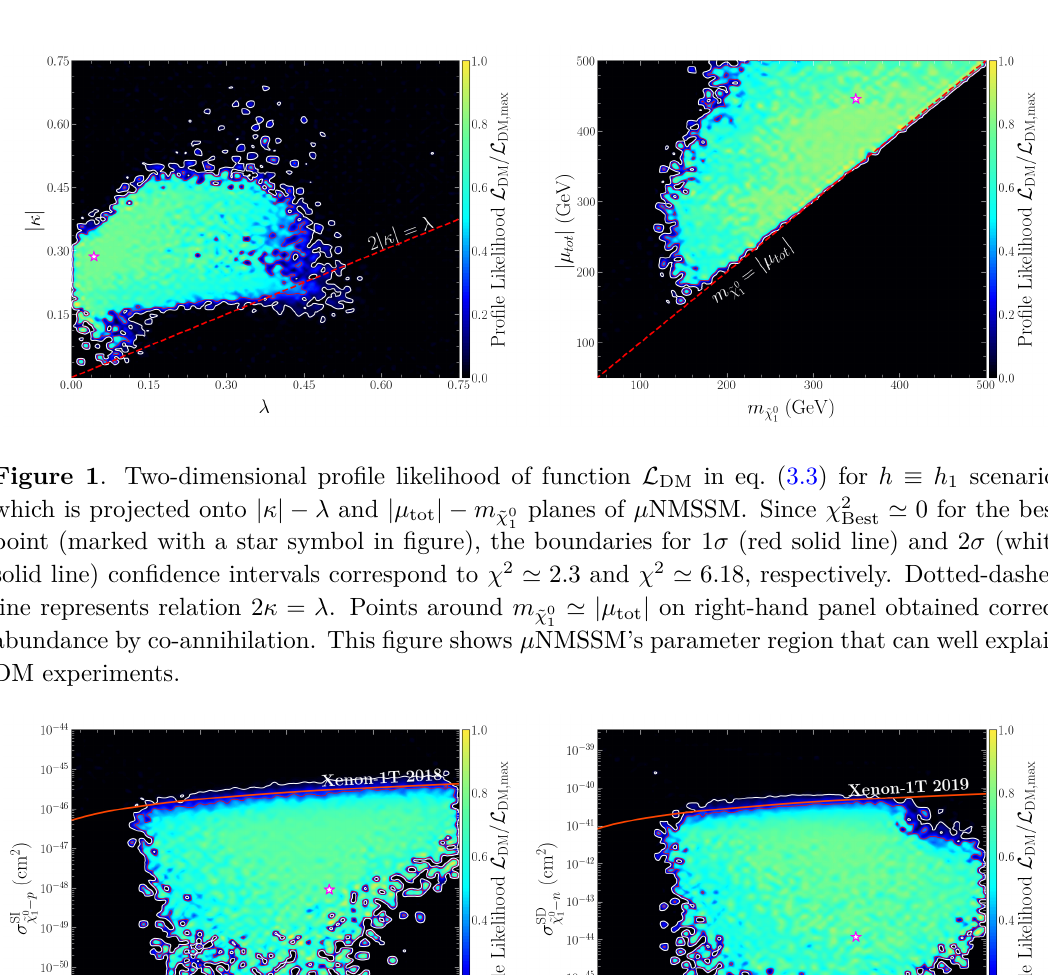
Figure 2 . Same as figure 1, but for profile likelihood projected onto σ SI plane. Red curve denotes latest XENON-1T’s bound on SI and SD